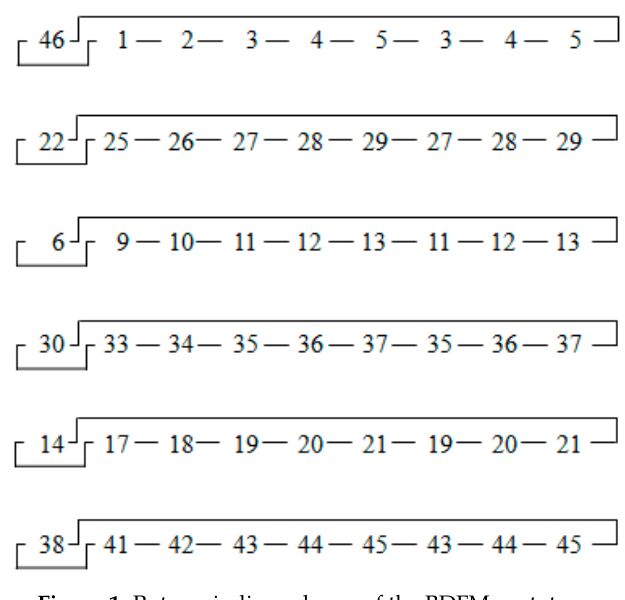
Figure 1. Rotor winding scheme of the BDFM prototype.